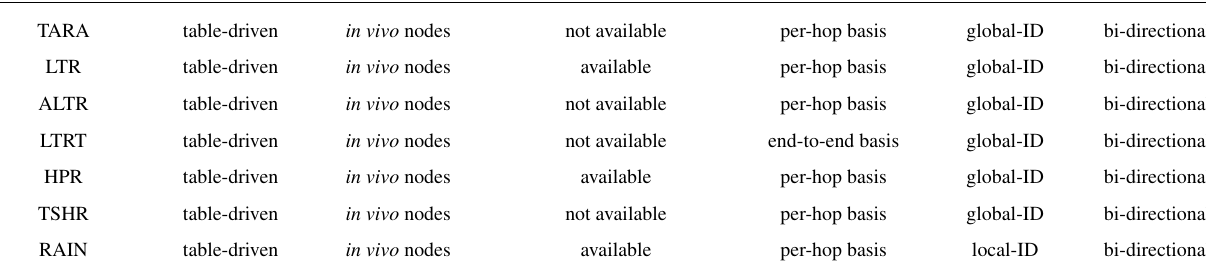
Table 1. Comparisons of temperature-aware routing protocols. HPR, Hotspot Preventing Routing; TSHR, Thermal-Aware Shortest Hop Routing; RAIN, Routing Algorithm for Network of Homogeneous and ID-less Biomedical Sensor